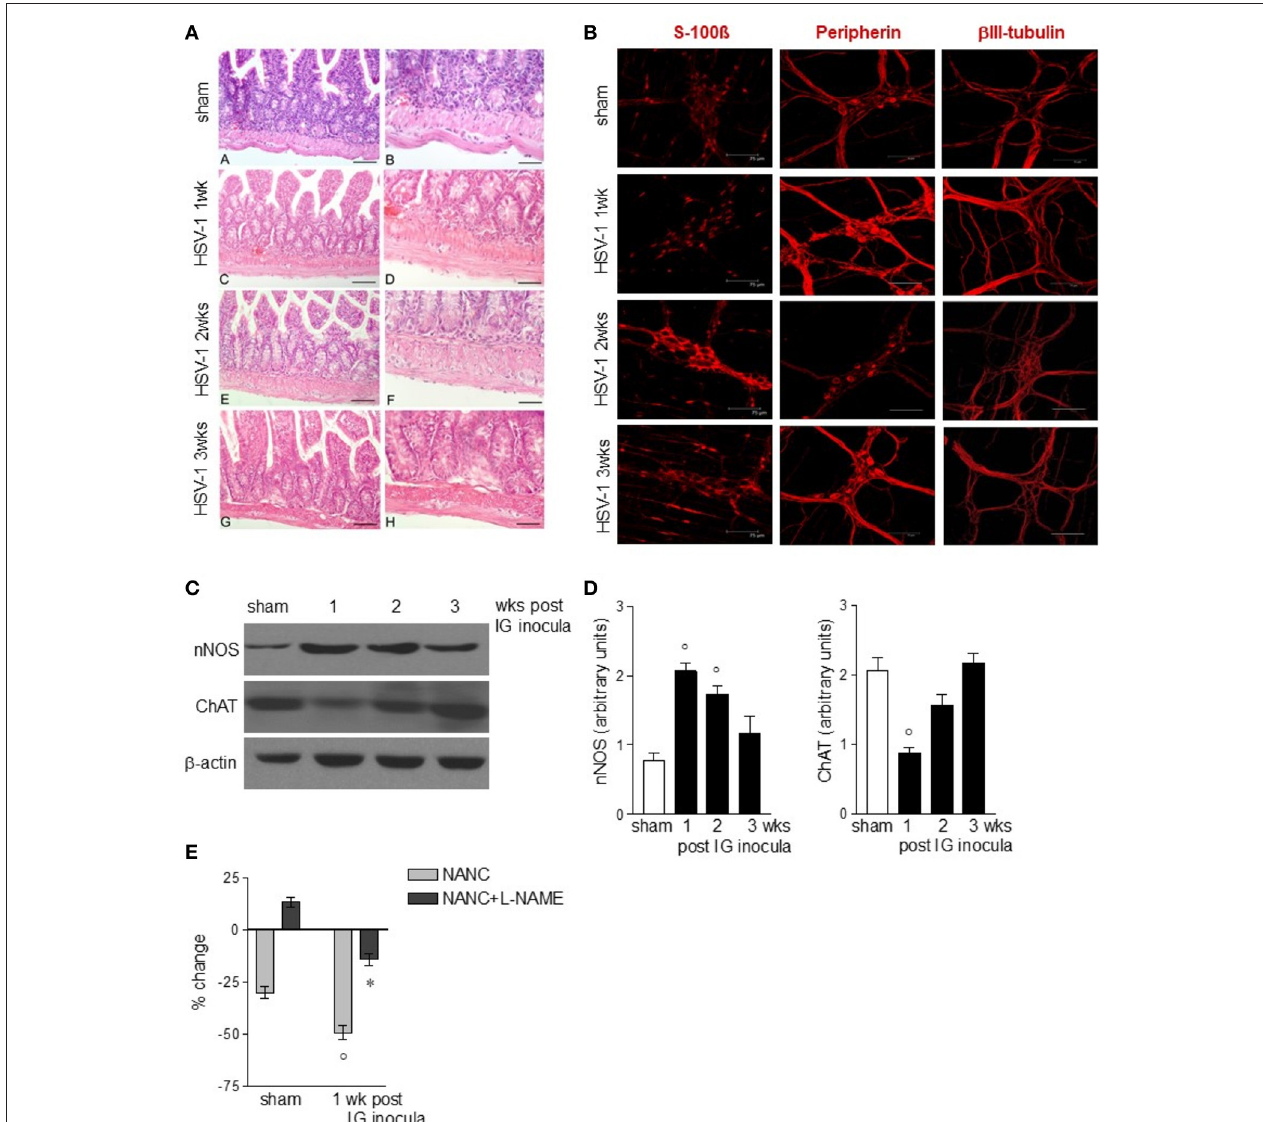
FIGURE 3 | Alterations in myenteric plexus during HSV-1 infection. (A) One, two, and three weeks post-IG infection with HSV-1 strain SC16, distal ileum was removed and fixed in neutral buffered formalin, embedded in paraffin, and subjected to H&E staining. Representative images are presented. Scale bars: 40 µ m in (left panels); 20 µ m in (right panels). (B) Samples of distal ileum were fixed to obtain whole mount preparations. Immunofluorescence analysis for S-100 β (glial marker), neurofilament peripherin, and neurotubules β III-tubulin was performed. Scale bars: 75 µ m. Representative images of three separate experiments. (C) Western Blot analysis of nNOS and ChAT in protein extracts from LMMP of sham and IG HSV-1 infected mice. β -actin was used as loading control. Images representative of three different blots with similar results are reported. (D) Protein signals were quantified using ImageJ and reported as arbitrary units. (E) Non-adrenergic, non-cholinergic (NANC) responses of segments of ileum obtained from sham and 1-week HSV-1 infected mice evoked by EFS in absence or presence of L-NAME. Percent change is expressed as change in grams of active tension before EFS-induced relaxation. Data are represented as mean ± SEM of at least two separate experiments. ◦ Denotes P < 0.05 compared to sham infected mice. *Denotes P < 0.02 compared to mice at 1 week of infection in absence of L-NAME.